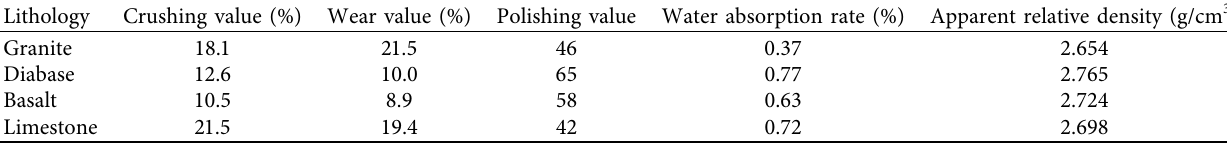
Table 1: Technical indices of the coarse aggregates.